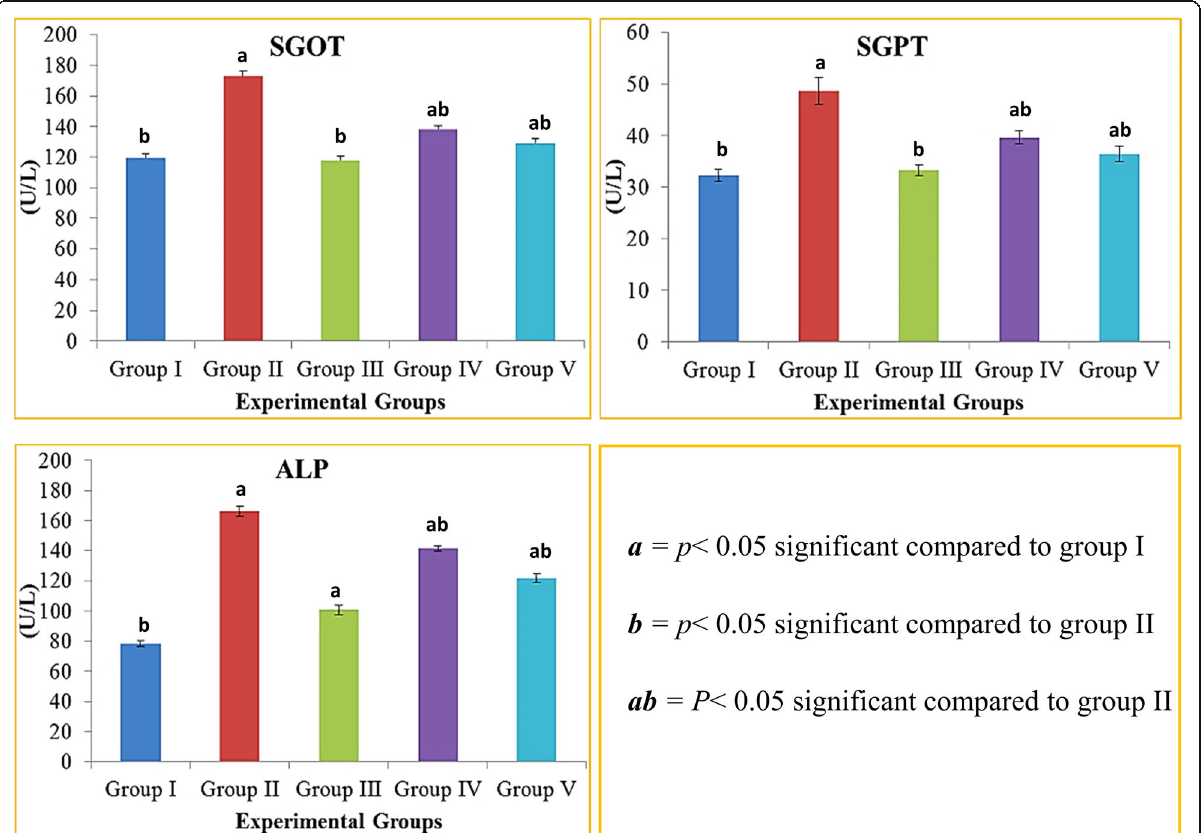
Fig. 5 ( a - c ) Effect of ethanolic extract of T. chebula on serum biochemical parameters responsible for monitoring the toxicity associated with the proper functioning of the liver. Values are expressed as mean ± S.D. Statistical significance ( p ) was calculated by one-way ANOVA followed by Tukey ’ s multiple comparison test. P < 0.05 was considered